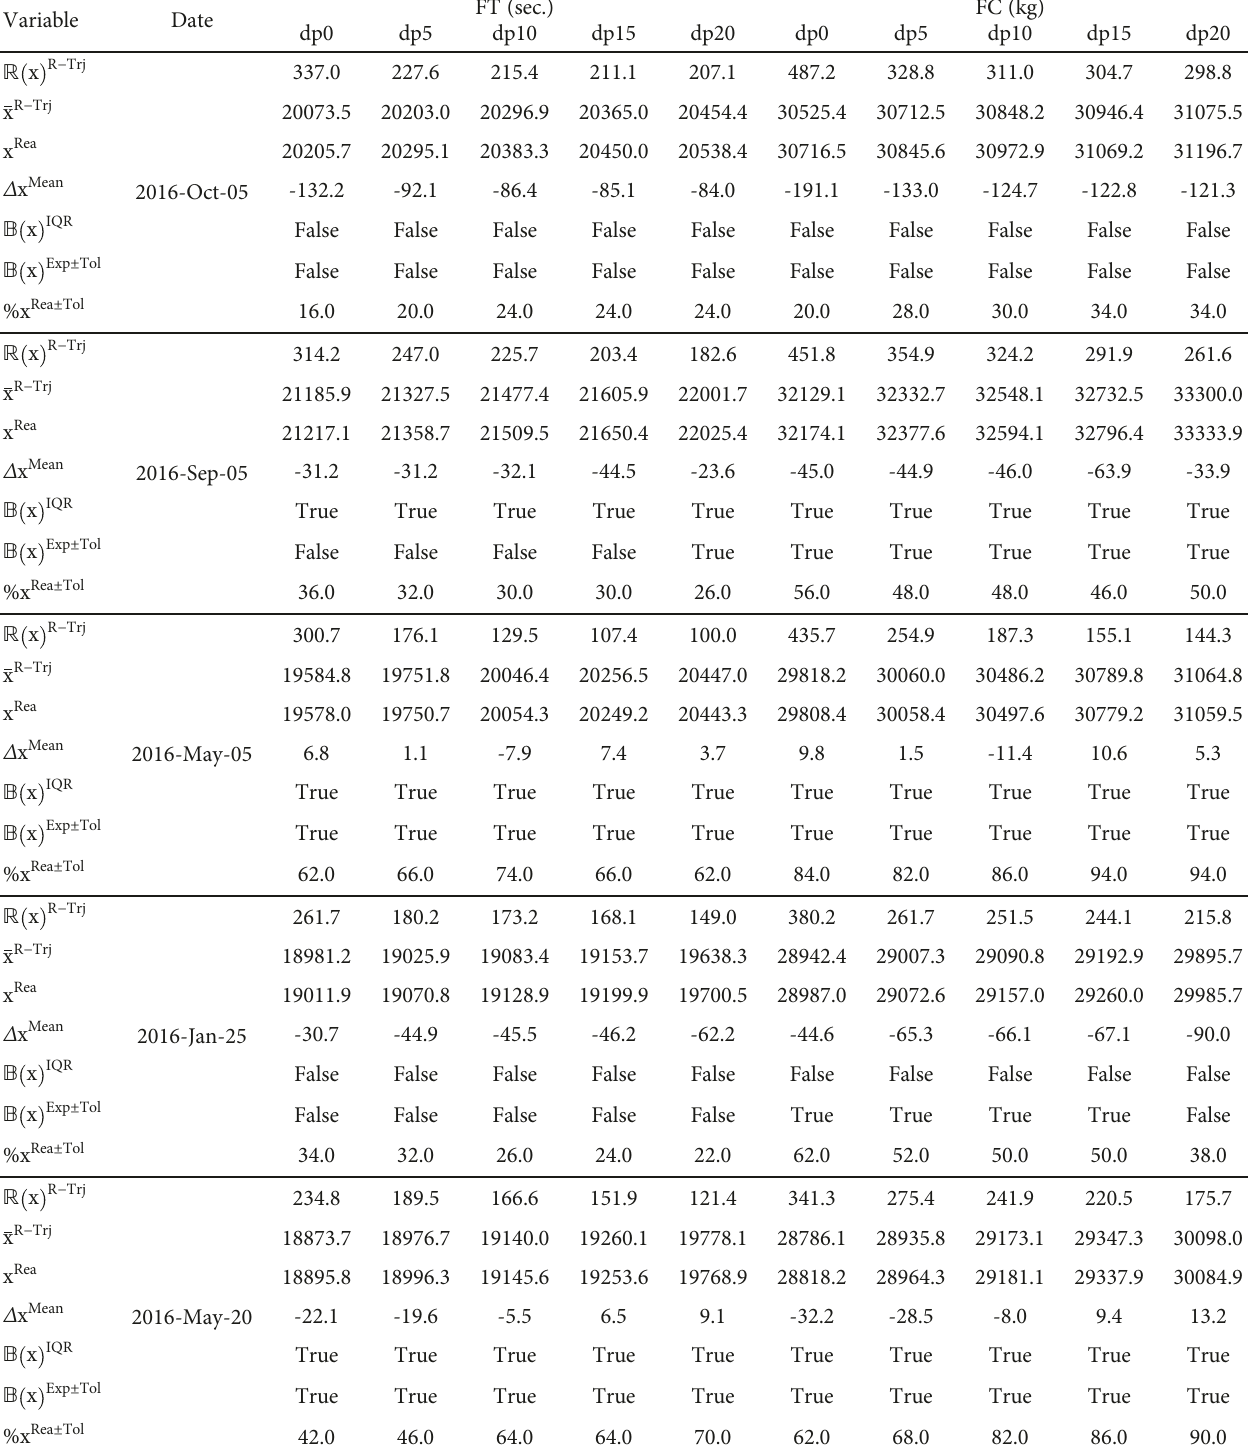
Table 1: Top fi ve days in terms of time and fuel dispersion. Tol = 30 sec (FT) and 70 kg (FC).